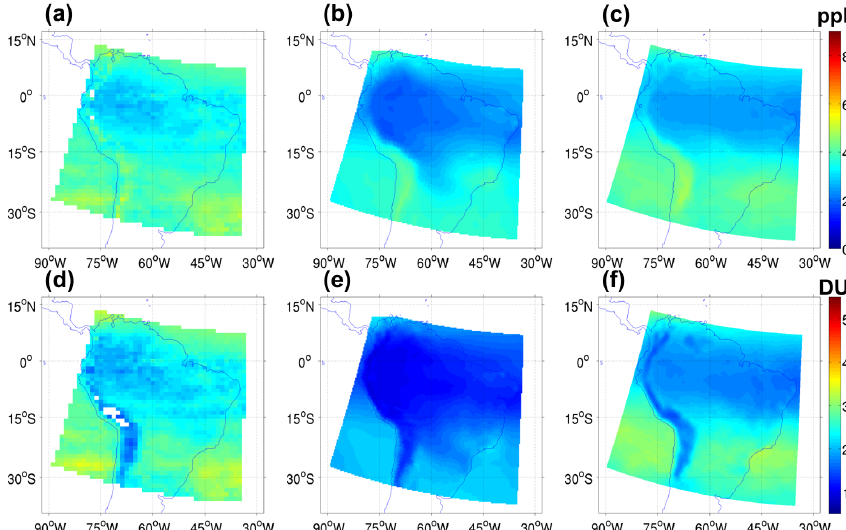
Figure 21. Same as Fig. 14, but for May